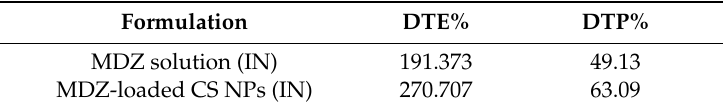
Table 6. Results of drug-targeting e ffi ciency (DTE%) and direct transport percentage (DTP%) of MDZ formulation following IN